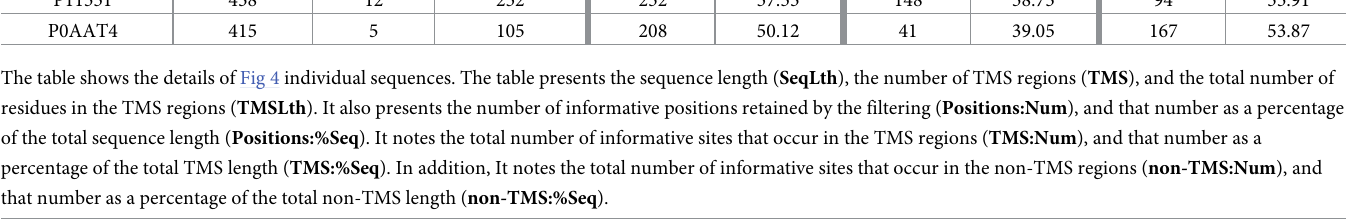
Table 9. Statistical analysis of informative position rates in TMS and non-TMS regions.